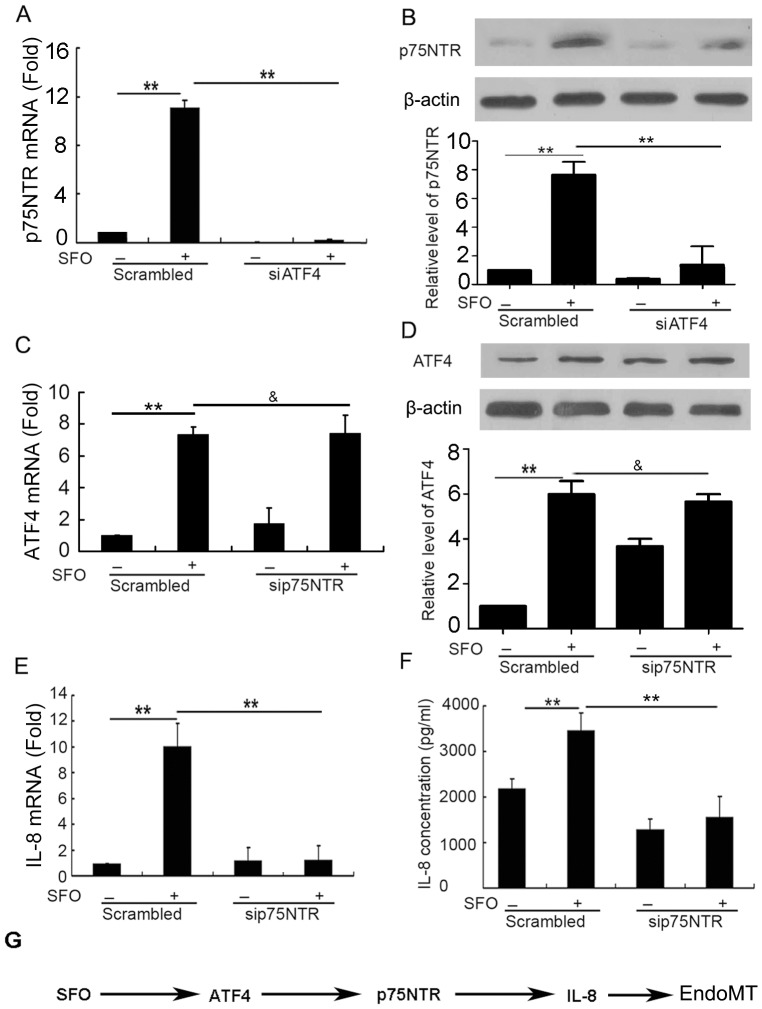
The ATF4/p75NTR/IL-8 signaling pathway was involved in the induction of EndoMT by SFO.(A and B) Cells were preincubated with ATF4 siRNA for 48 h, then 50 µg/ml SFO for 3 h for qPCR assay and 6 h for western blot assay. Effect of ATF4 siRNA on SFO-induced p75NTR expression in HUVECs was detected by qPCR assay (A) and western blot assay (B). Data below gels were used to quantify the density of the bands. (C to F) Cells were preincubated with p75NTR siRNA for 48 h, then 50 µg/ml of SFO for 3 h for qPCR assay and 6 h for western blot or ELISA assay. Effect of p75NTR siRNA on SFO-induced ATF4 expression in HUVECs was detected by qPCR assay (C) and western blot assay (D). Effect of p75NTR siRNA on SFO-induced IL-8 expression and release in HUVECs was detected by qPCR assay (E) and ELISA (F). G. A schematic of the signaling pathways of SFO in HUVEC transdifferentiation. (**p<0.01; & p>0.05, n = 3).